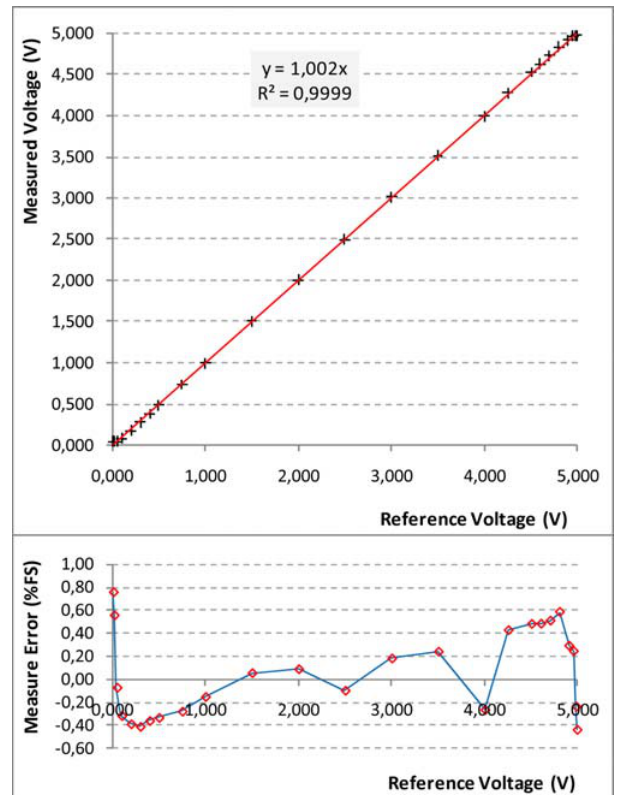
Figure 15. Results of characterization test carried out on UISI Conditioned Sensor configuration. Top graph show the measured voltage vs. the reference voltage; Bottom graph shows the corresponding error in Full Scale (FS)